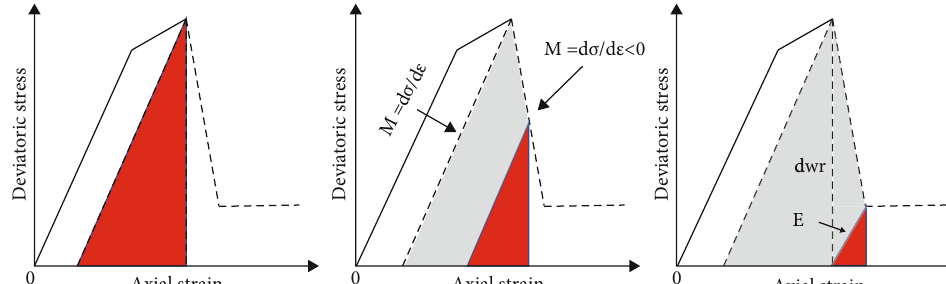
Figure 11: Schematic diagram of brittleness index B